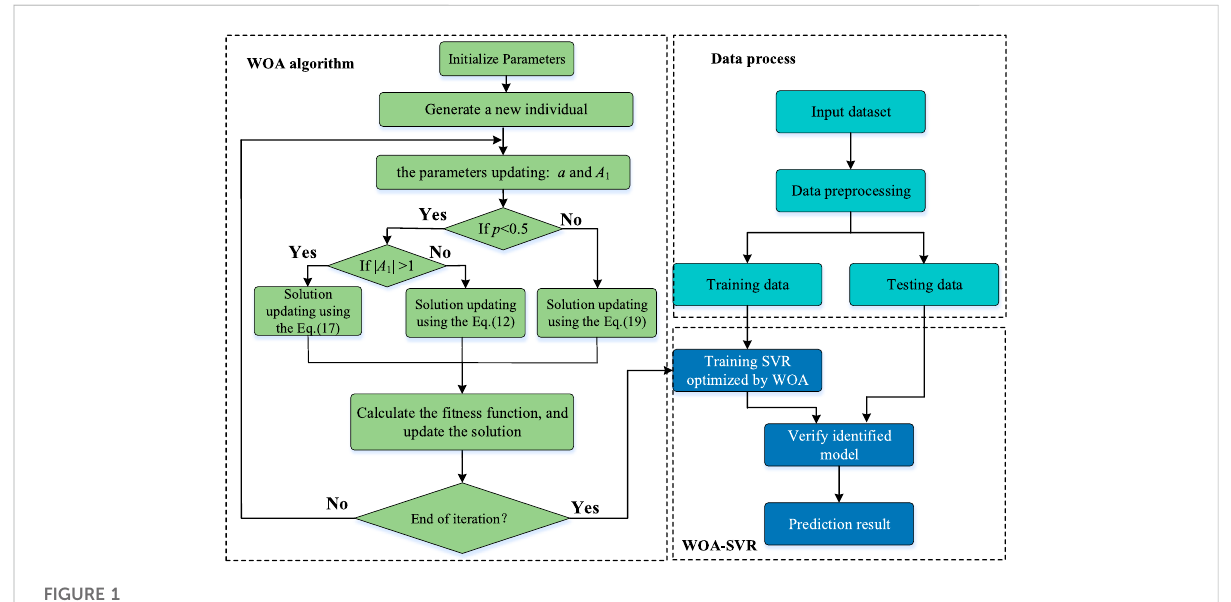
FIGURE 1 Flowchart of the WOA-SVR